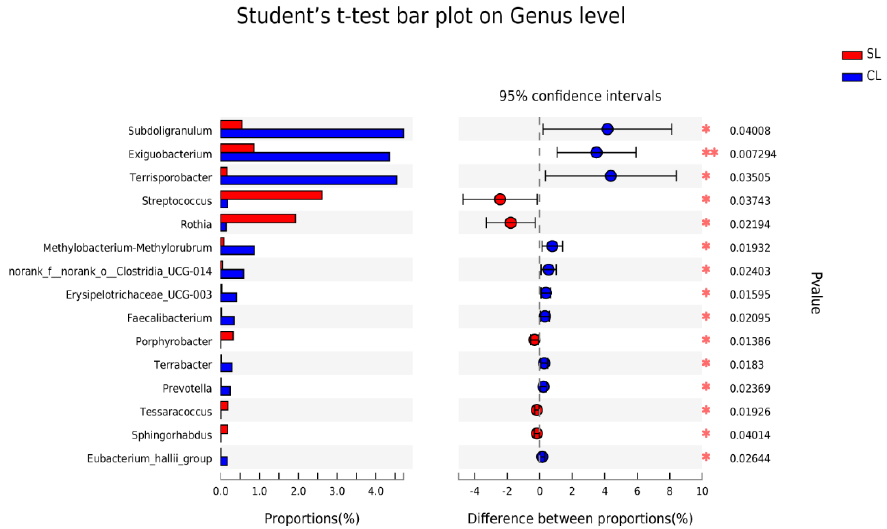
Figure 4. Column chart of intestinal multi − species difference test of SL and CL Anser fabalis. The p value: * p < 0.05; ** p < 0.01.